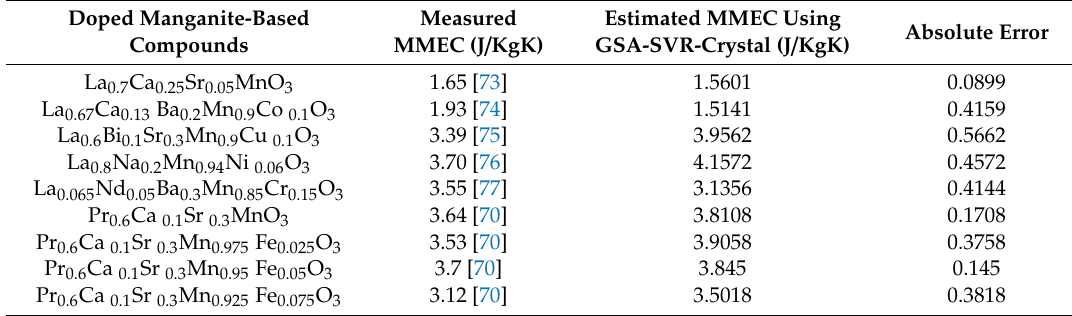
Table 5. Comparison between the results of the developed GSA-SVR-crystal model and the measured values of the MMEC for di ff erent classes of manganite-based